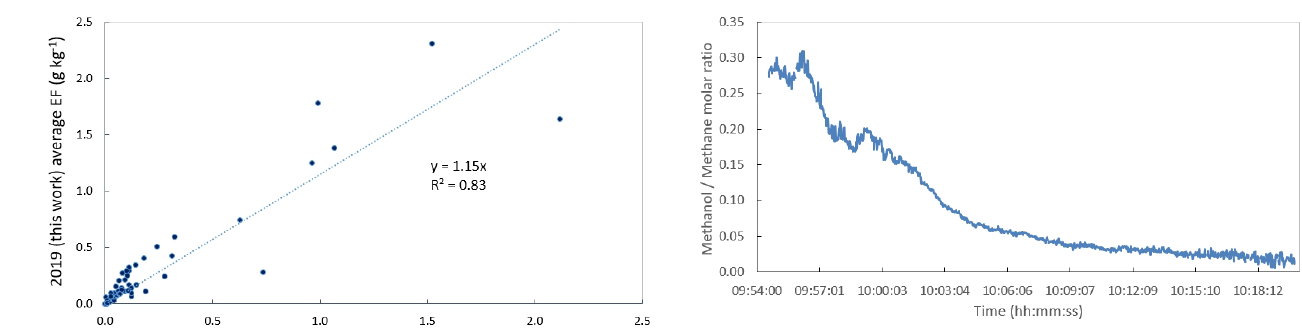
Figure 6. Methanol is an indicator of pyrolysis of fresh fuel, while methane indicates gasification of charred fuel. The ratio of methanol to methane drops from near 0.3 to about 0.013 (a factor of ∼ 23) over 25min while burning an approximately 1kg sample of Kali- mantan peat as fire no. 114 during FLAME-4 in